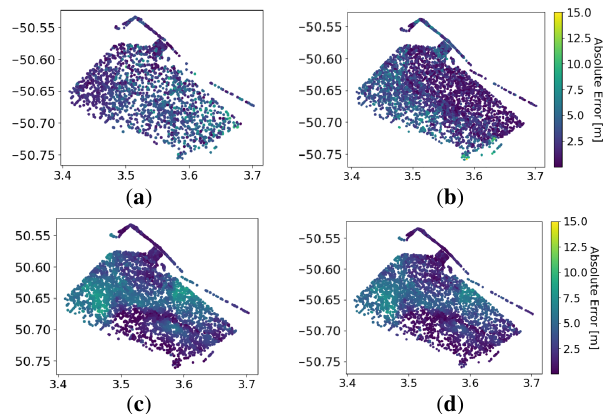
Figure 8. RMSE score comparison of S2Shores ( a ), W-DSPEB ( b ), C-DSPEB( c ) and H-DSPEB ( d ).